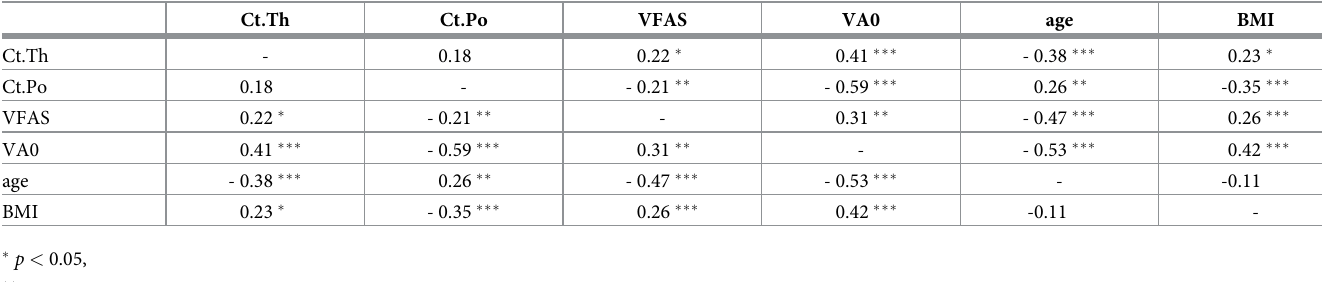
Table 2. Spearman’s correlation coefficients R between BDAT parameters, age and BMI, for the first population (106 patients). Ct.Th